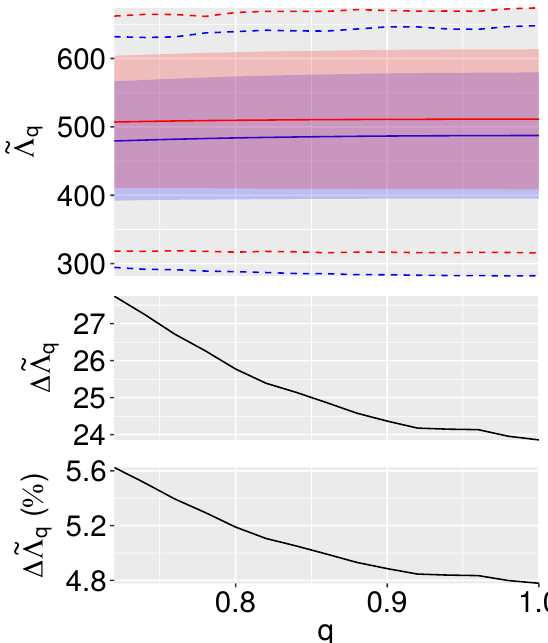
Figure 5. Top panels: Effective tidal deformability of the binary, ˜ Λ , as a function of q for M chirp = 1.186 M (cid:12) . The mean (solid line), ± 2 σ (filled region), and max/min values (dashed lines) are shown for each dataset, P ( µ ) (blue) and P ( (cid:101) ) (red). Middle panels: Difference between mean values, ¯˜ Λ ∆ ˜ Λ = | ¯˜ Λ (cid:101) − µ | . Bottom panels: Relative difference (%), defined by where ¯˜ Λ = ( ¯˜ Λ (cid:101) + ¯˜ Λ µ )